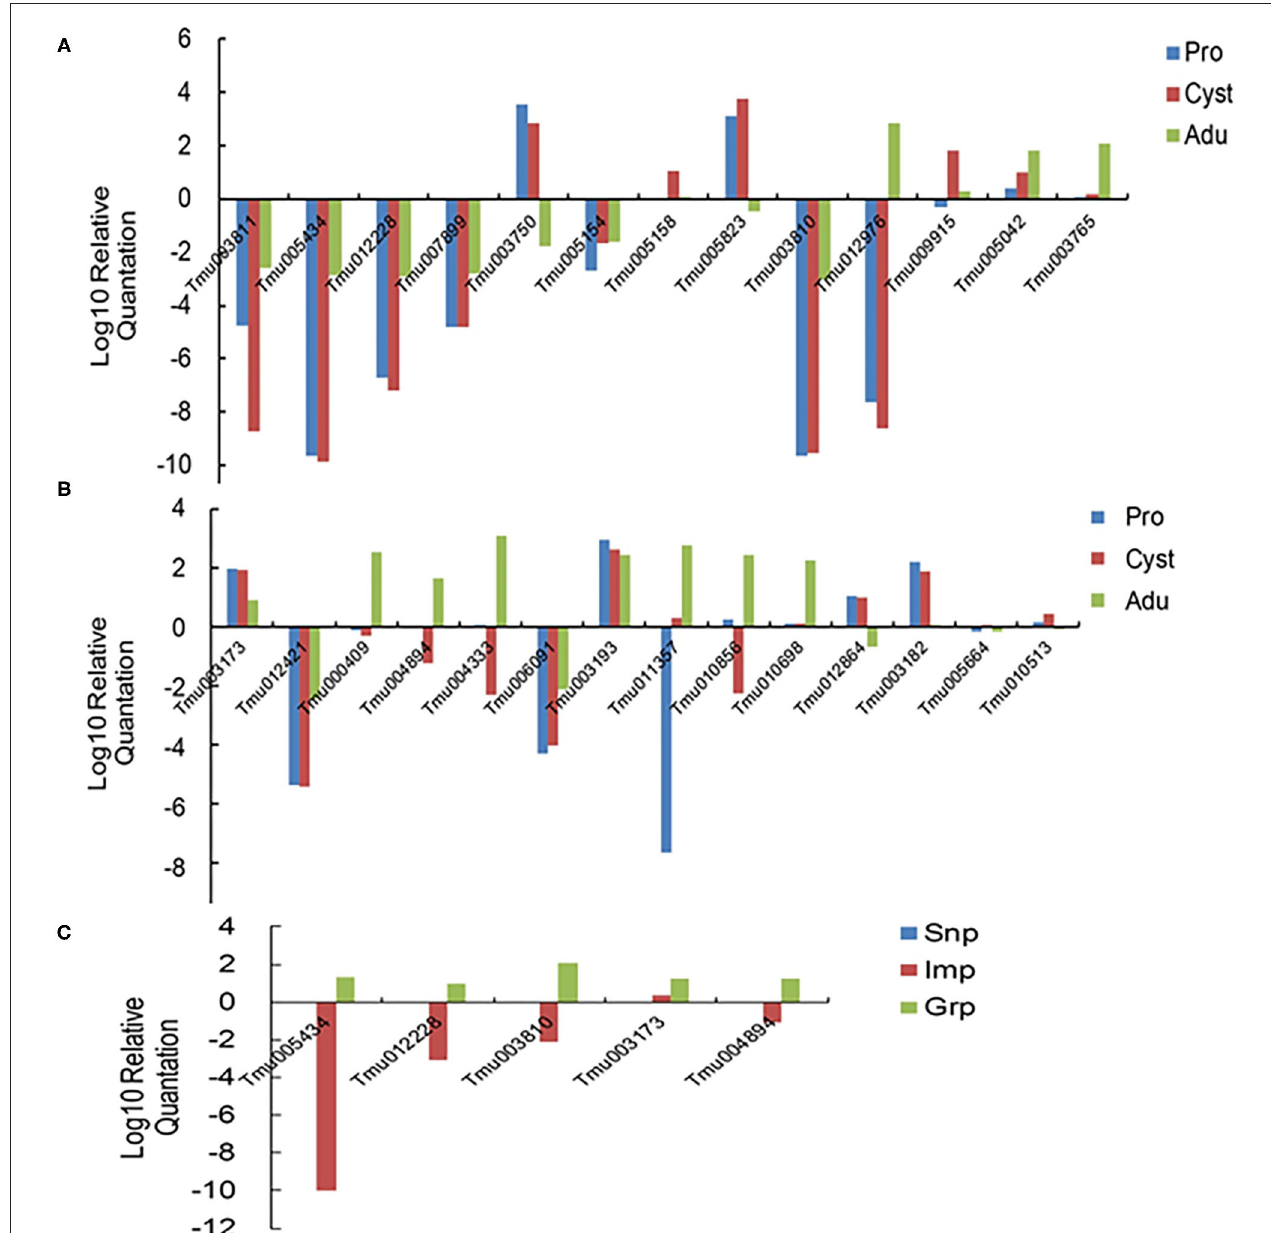
FIGURE 5 | Relative expression levels of the 28 selected DEGs determined using qRT-PCR. (A,B) Confirmation of the DEGs in the developmental stages of T. multiceps . (C) Confirmation of the DEGs in different tissues in the adult stage of T. multiceps